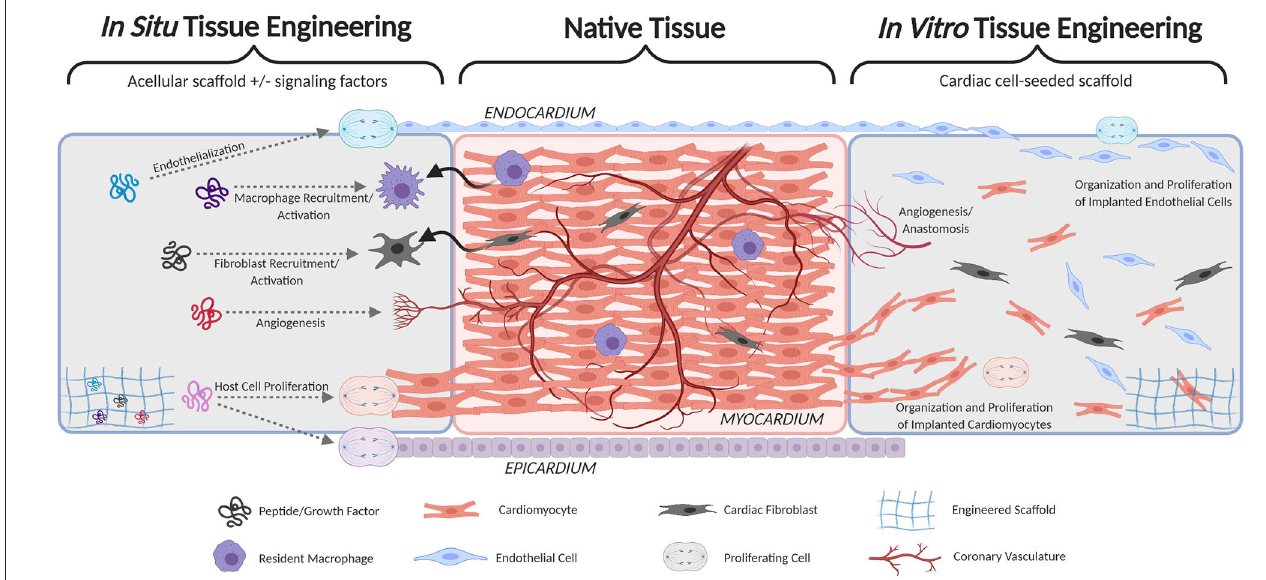
FIGURE 1 | Schematic comparison of cardiac patches implementing in situ cardiac tissue engineering (left) and in vitro cardiac tissue engineering (right). Both seek to fully integrate with native host tissue (middle) by forming continuous endocardium, myocardium, epicardium, and vasculature.